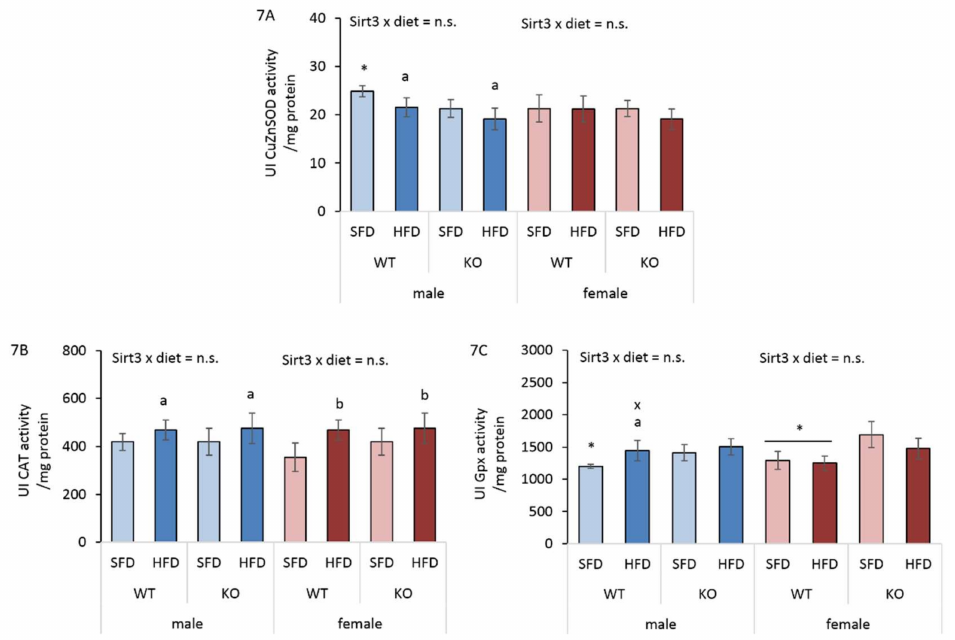
Figure 7. Analysis of CuZnSOD, Cat, and Gpx1 activities in the livers of Sirt3 wild-type (WT) and knockout (KO) mice of both sexes fed with a standard fat diet (SFD) or a high fat diet (HFD) for 10 weeks. ( A ) CuZnSOD activity. Males: HFD-fed vs. SFD-fed mice ( a p < 0.05); SFD-fed WT vs. KO mice (* p < 0.05); Females: no changes. Males vs. females: no changes. ( B ) Cat activity. Males: HFD-fed vs. SFD-fed mice ( a p < 0.05). Females: HFD-fed vs. SFD-fed mice ( b p < 0.01). Males vs. females: no changes. ( C ) Gpx1 activity. Males: HFD-fed vs. SFD-fed WT mice ( a p < 0.05); SFD-fed WT